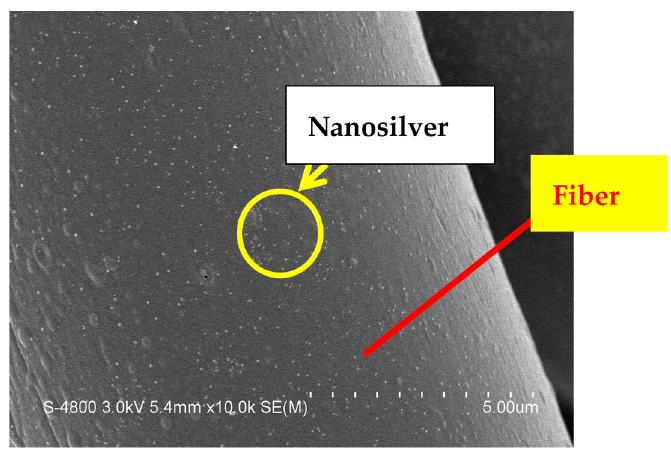
Figure 1. Scaning electron microscopy (SEM) observation of nanosilver-doped nonwoven fibers.